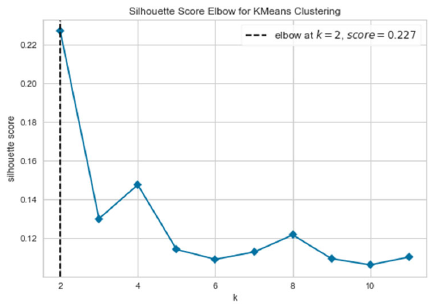
Fig. 9. Silhouette score Elbow for K-Means Fig. 10. Calinski Harabasz score Elbow for